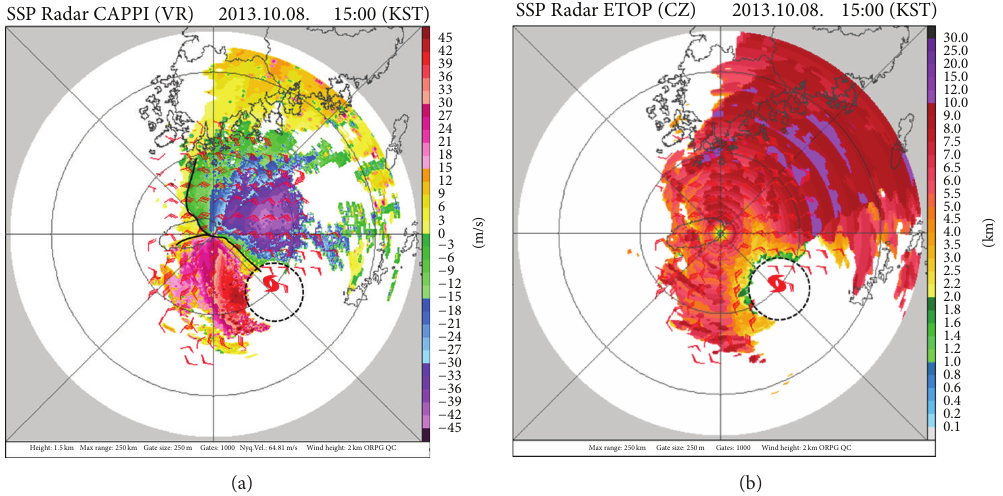
Figure 7: The PIs (circles) and the estimated centers (markers) of Typhoon DANAS (1324) at 06 UTC October 8, 2013, using radar imagery from KMA: CAPPI (VR) (a) and echo top (CZ) (b).